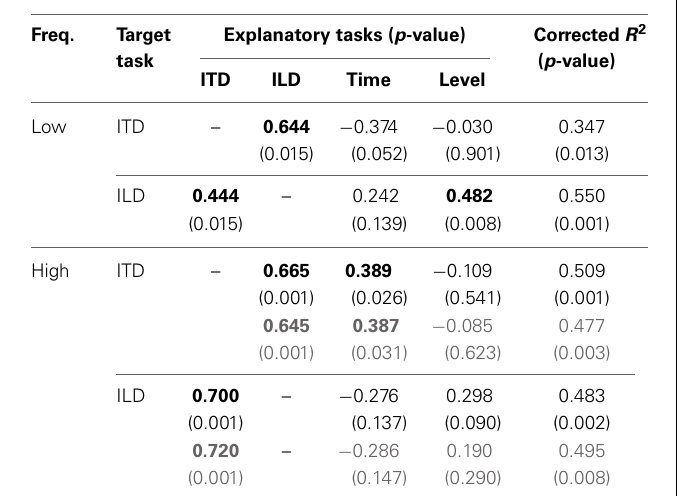
Table 1 | Summary of multiple regression analyses for low- and high-frequency stimuli.